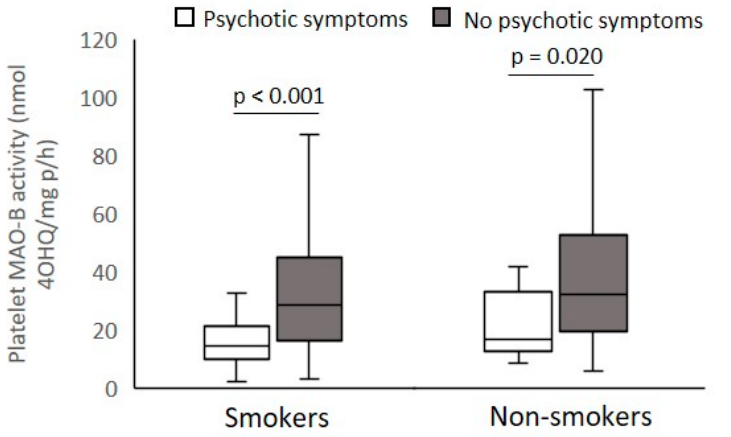
Figure 5. Platelet MAO-B activity in subjects with severe and mild symptoms evaluated by the PANSS-psychotic subscale, subdivided according to smoking status.